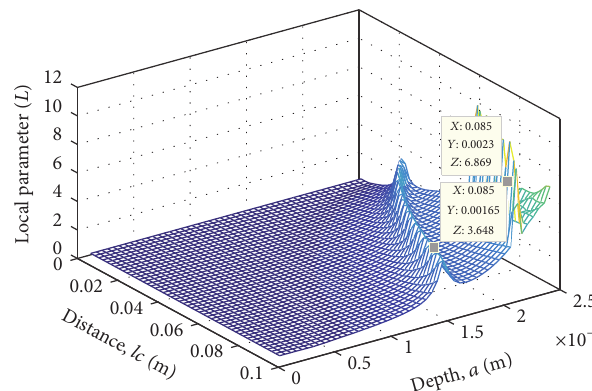
Figure 18: Relations between LPVRs and parameter changes of a crack.